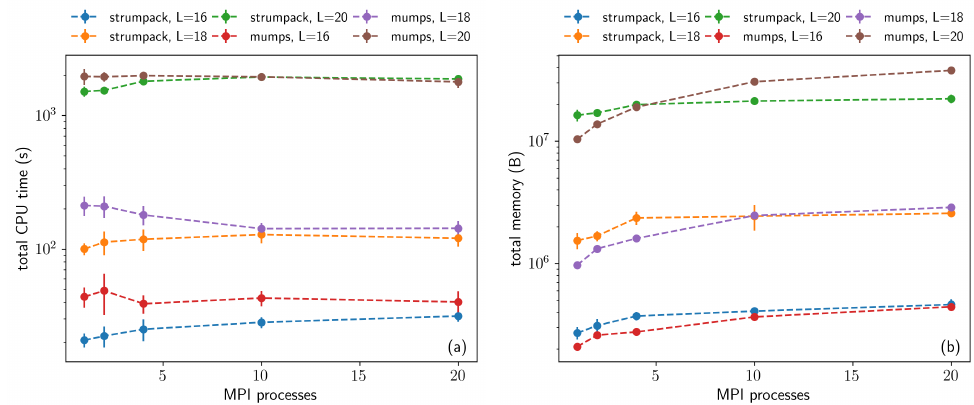
Figure 2: Total CPU time (a) and total memory as reported by the operating system (b) used for shift-invert runs for chains of size L ≤ 20, which fit on one node. We average all results over a few disorder realizations, although, as we will show in subsection 4.2, fluctuations in the benchmarked quantities are small.